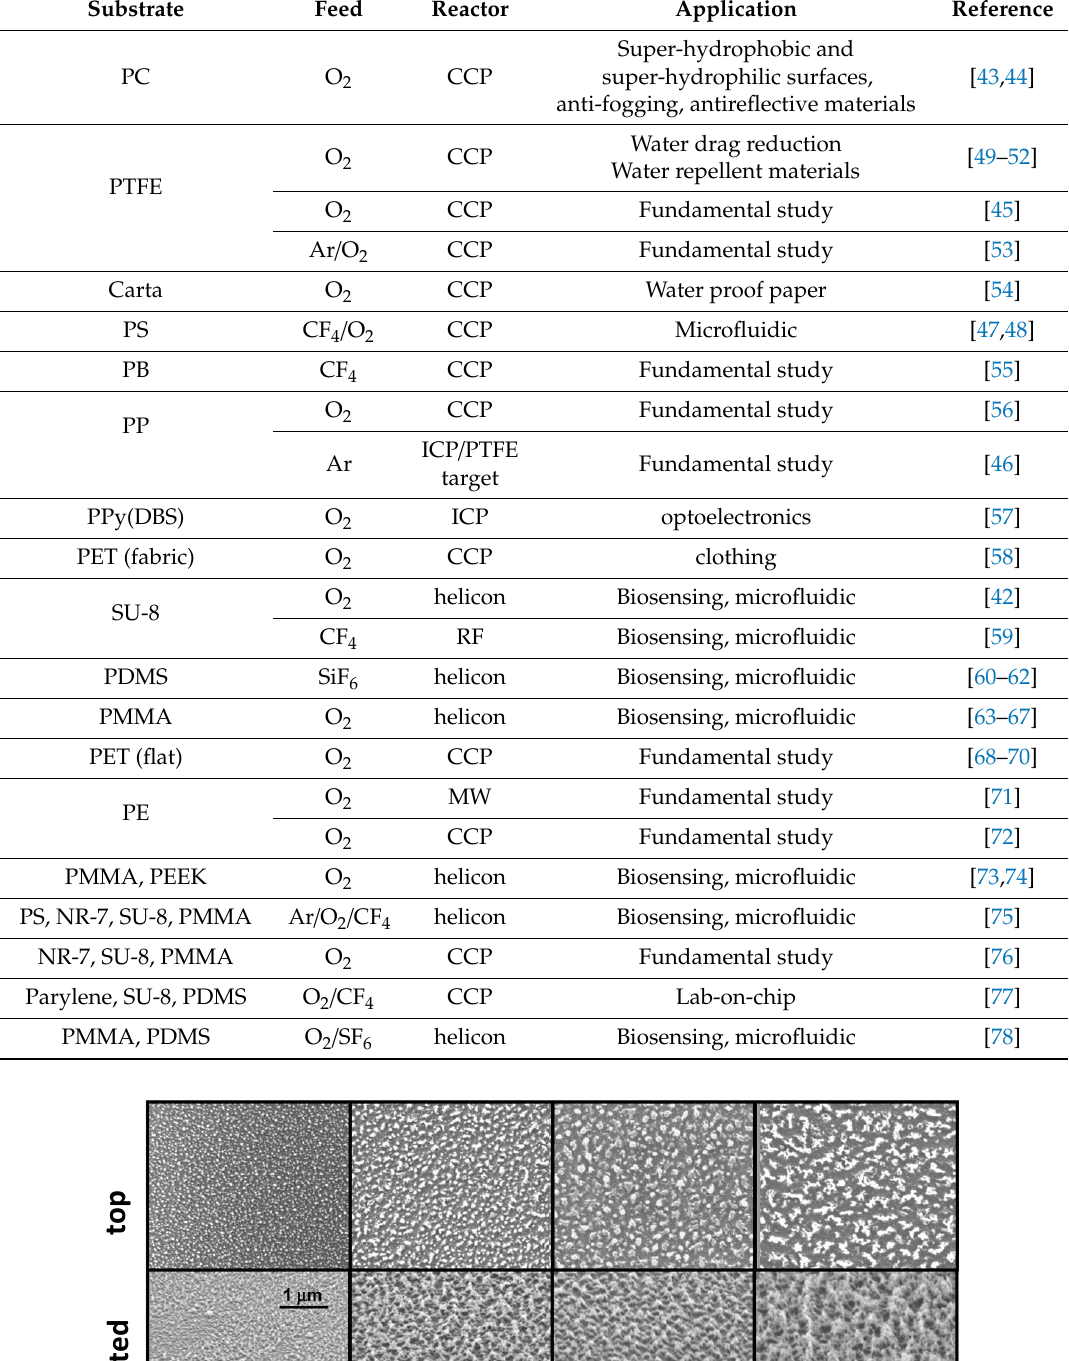
Table 2. Examples of the plasma nano-texturing of di ff erent polymers, with indication of the gas feed and reactor configuration used. ICP stands for “inductive coupled plasma”.